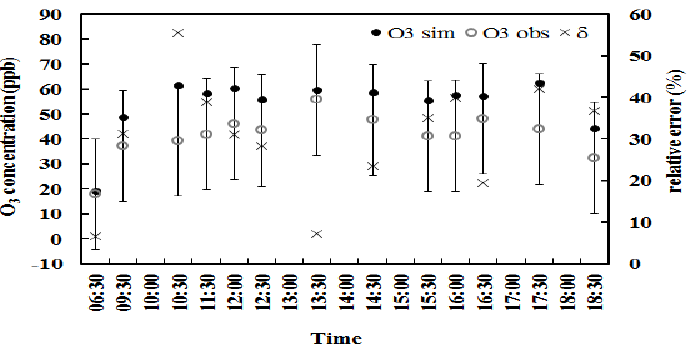
Figure 3. The simulated and observed mean half-hourly O 3 concentrations with error bars indicating 2 standard deviations of observed O 3 (n = 104) in 2013 and the relative biases ( δ , %) for situation A. Similarly, validation for the O 3 empirical model considering monoterpene roles was conducted using the observational data in 2013. (1) The mean half-hourly variation was estimated and given in Figure 4 (n = 104). The simulated O 3 overestimated the observed O 3 (43.8 vs. 41.0 ppb) by 7%. (2) The calculated and observed O 3 mean concentrations were 45.3 and 41.6 ppb (n = 104) for single measurements during 2013, respectively, i.e., the simulated O 3 overestimated O 3 by 9%. The NMSE and RMSE values were 0.1063 and 18.1 ppb, respectively. These uncertainties were reduced compared to that considering the isoprene role, which is mainly due to the monoterpene emissions are the summation of main monoterpene compositions and the random error reduction in the measurements. The comparisons of RMSE values for the O 3 empirical model and chemical models are shown in Section 4.3.